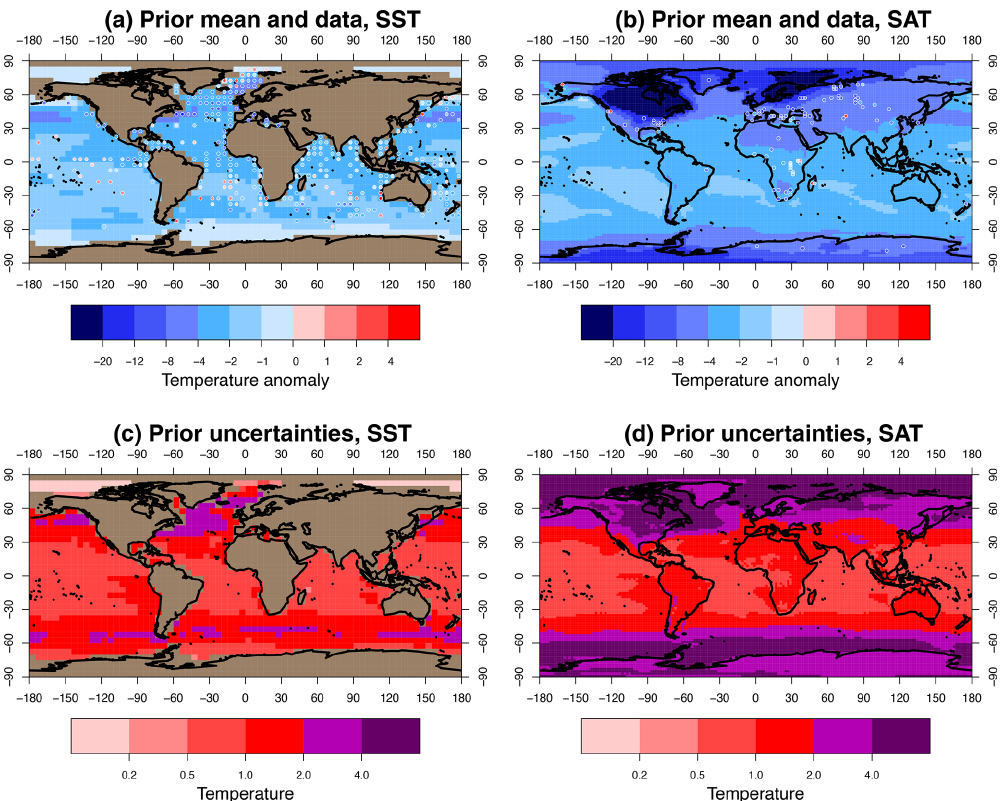
Figure 2. The prior: translated ensemble mean and data. Panels (c) and (d) show uncertainties. SST and SAT are shown in (a, c) and (b, d) .